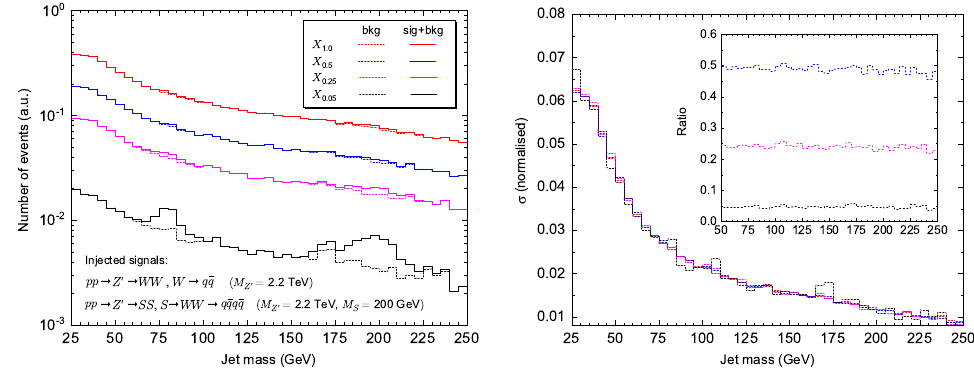
Figure 5 . Left: jet mass distribution for the SM background plus two injected signals, after the application of increasingly tighter cuts on the NN score. Right: normalised background distributions before and after cuts (main plot), and ratios of distributions after/before cuts (inner plot) — see the